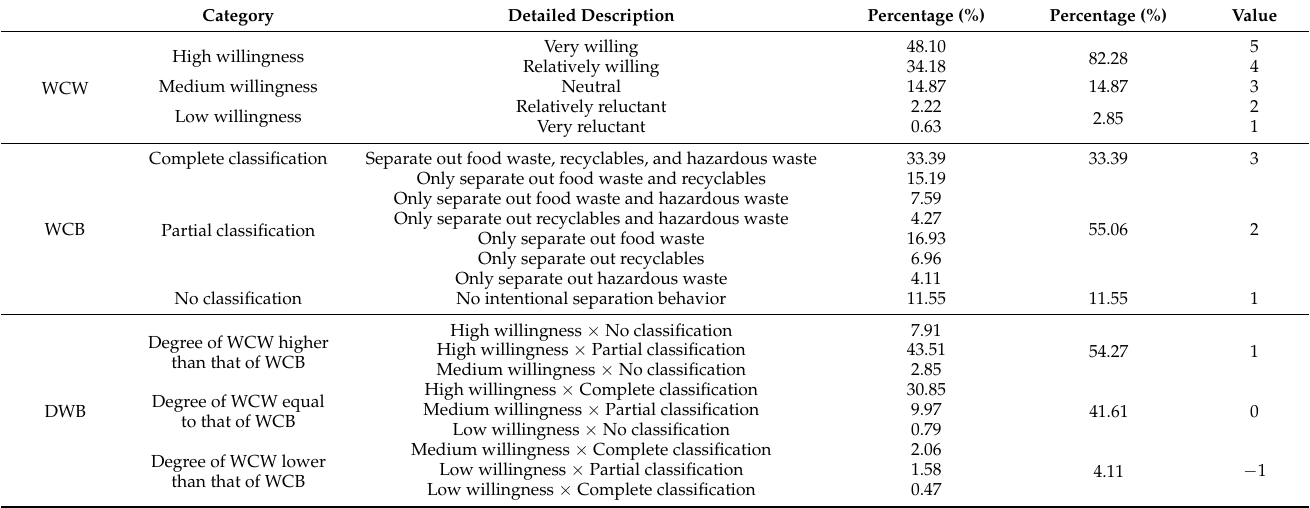
Table 3. Description statistics of willingness, behavior, and deviation from DWC.